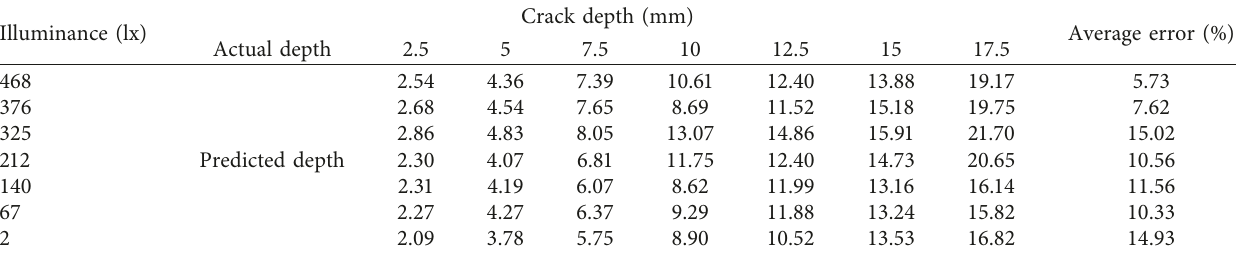
Table 6: Experimental results of verification on empirical equations.